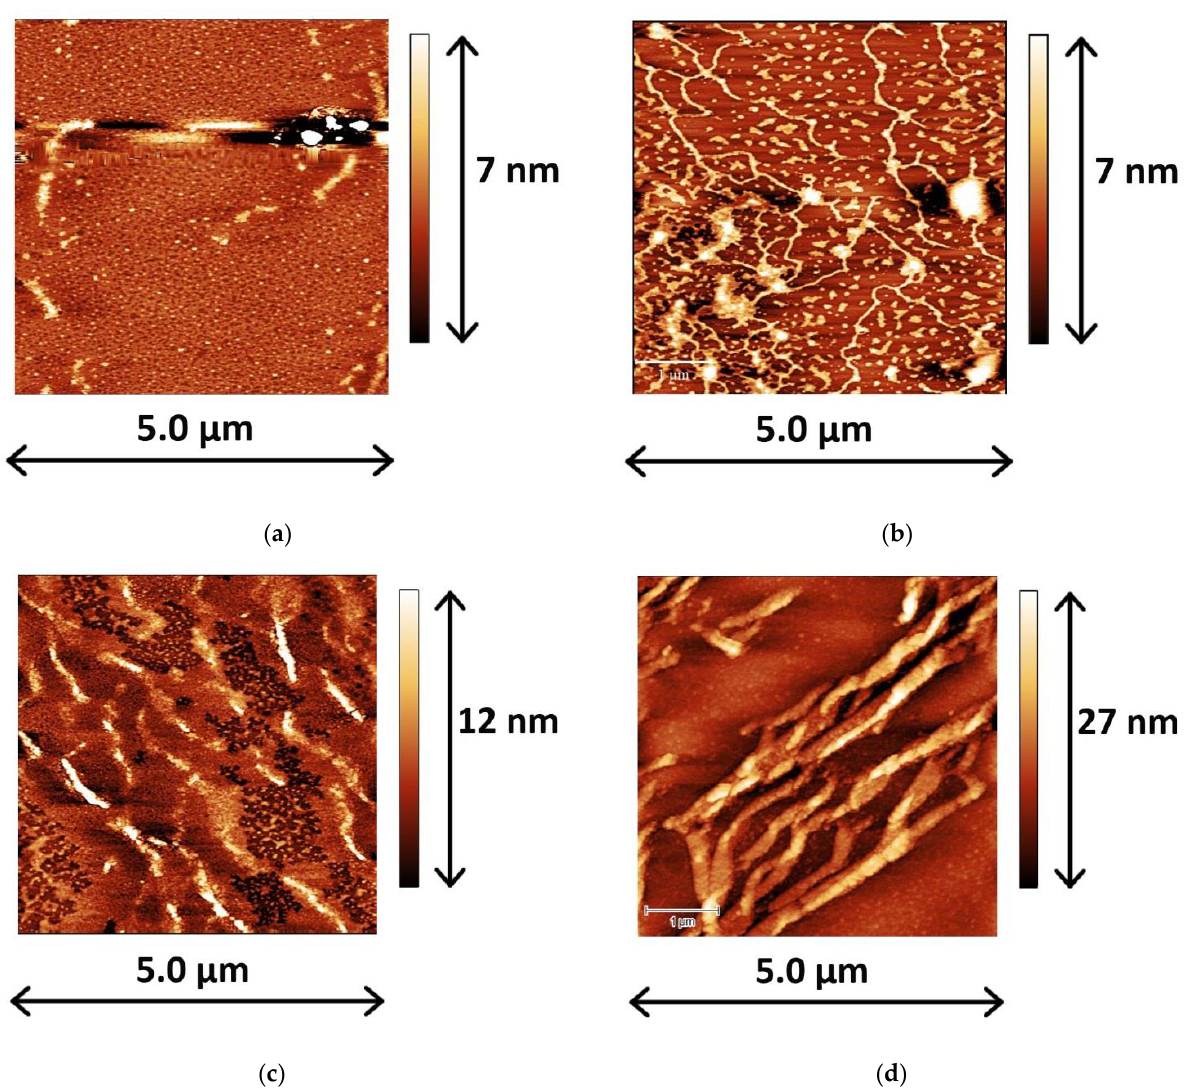
Figure 3. AFM images of a lysozyme layer transferred onto the mica surface at a surface pressure of 10 mN/m ( a ) and mixed lysozyme/DNA layers transferred onto a mica surface at surface pressures of 10 ( b ), 20 ( c ) and 30 ( d ) mN/m. The total DNA concentration is 50 μM .